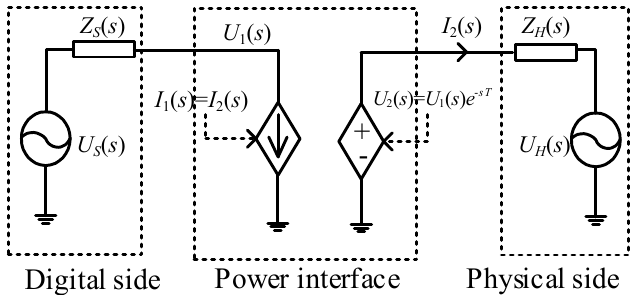
Figure 2. Equivalent circuit of the DPHS based on a voltage-source-ITM (ideal transformer method). In Figure 2, U S ( s )/ Z S ( s ) and U H ( s )/ Z H ( s ) are the equivalent voltage source/impedance of the digital and physical subsystem respectively. U 1 ( s ) and I 1 ( s ) are the voltage and current at the port of the digital subsystem interfacing with the power interface unit, U 2 ( s ) and I 2 ( s ) represent the actual